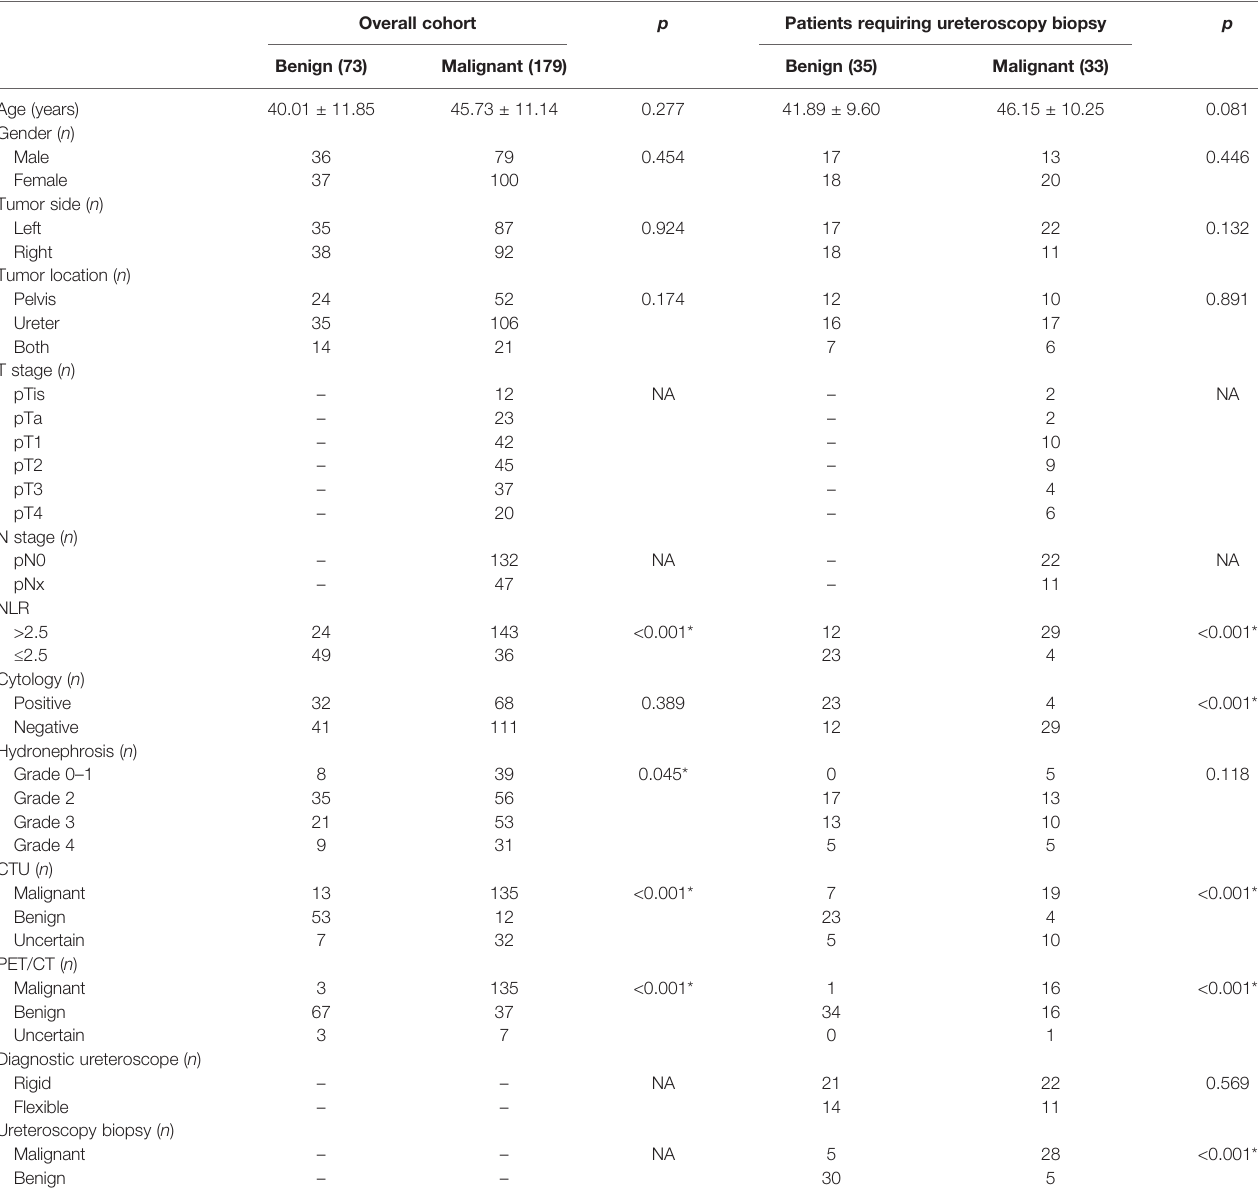
TABLE 2 | Clinicopathologic data between the benign group and the malignant group of UUT